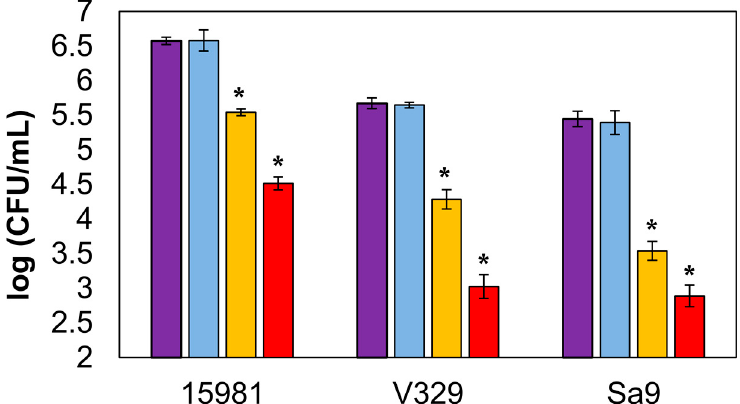
Figure 3. Lytic activity of liposome-encapsulated LysRODI against biofilms formed by S. aureus 15981 (polysaccharide biofilm former strain), S. aureus V329 (protein biofilm former strain), and S. aureus Sa9 (poor polysaccharide biofilm former). Purple bar: untreated control biofilm; light blue bar: biofilm treated with empty liposomes; yellow bar: biofilm treated with encapsulated LysRODI; red bar: biofilm treated with free LysRODI. *, p -value < 0.05.